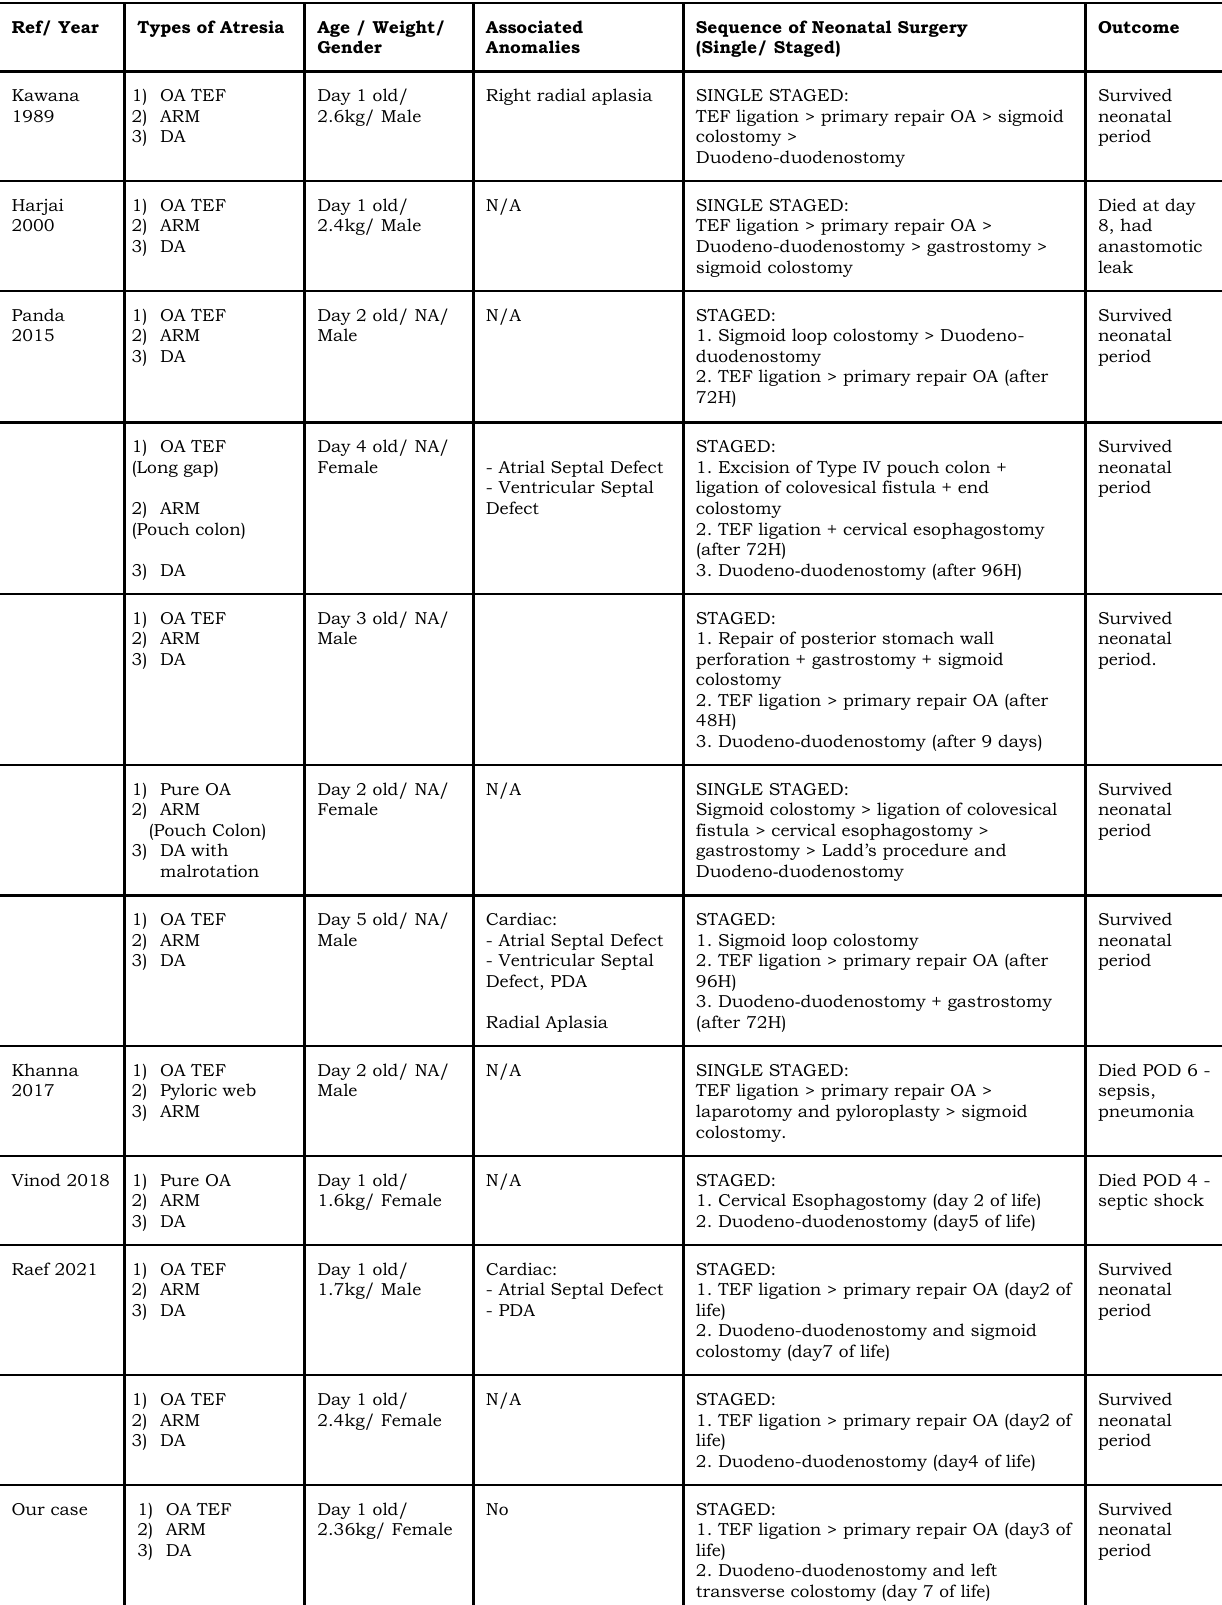
Table 1: Summary of triple atresia literature